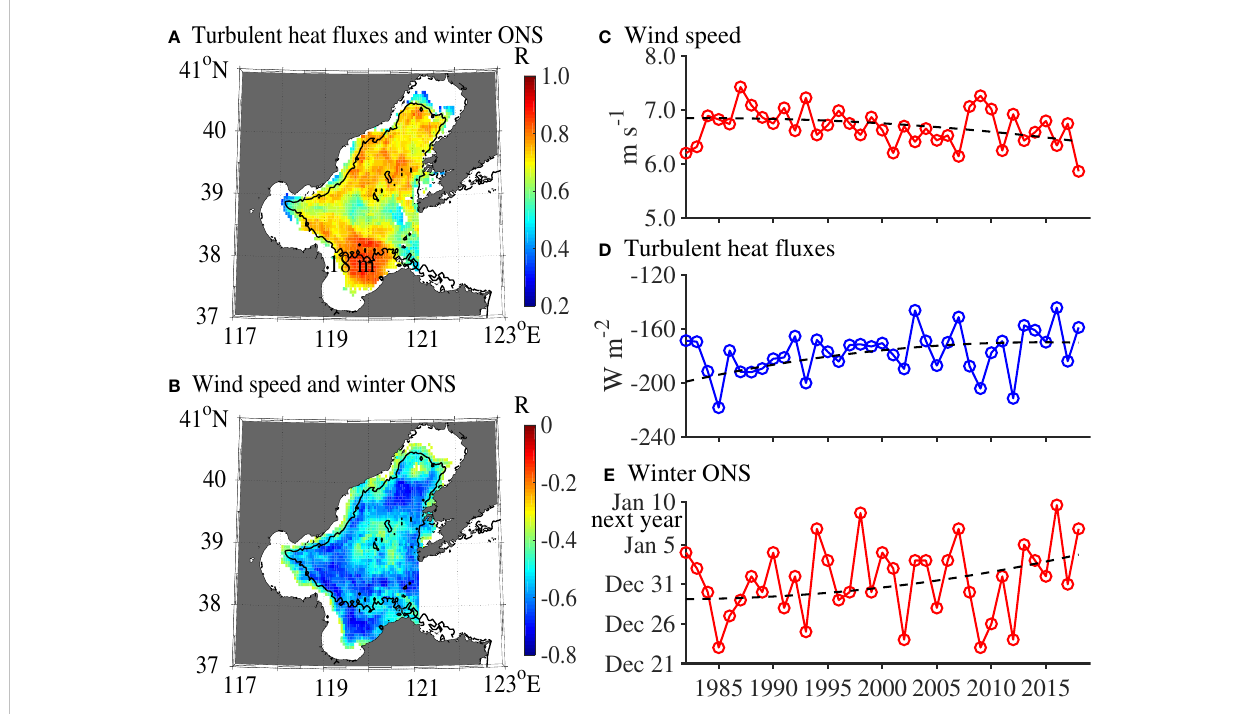
FIGURE 8 Correlation coef fi cients between time series of (A) the late fall turbulent heat fl uxes and the winter ONS, (B) the late fall wind speed and the winter ONS. Only signi fi cant correlations at the con fi dence level of 95% are shown in the ice-free regions of the Bohai Sea. Black contour is the same as Figure 4. Spatially averaged time series of (C) the late fall wind speed, (D) the late fall turbulent heat fl uxes and (E) the winter ONS during 1982 – 2018. Black dash line is the same as Figure